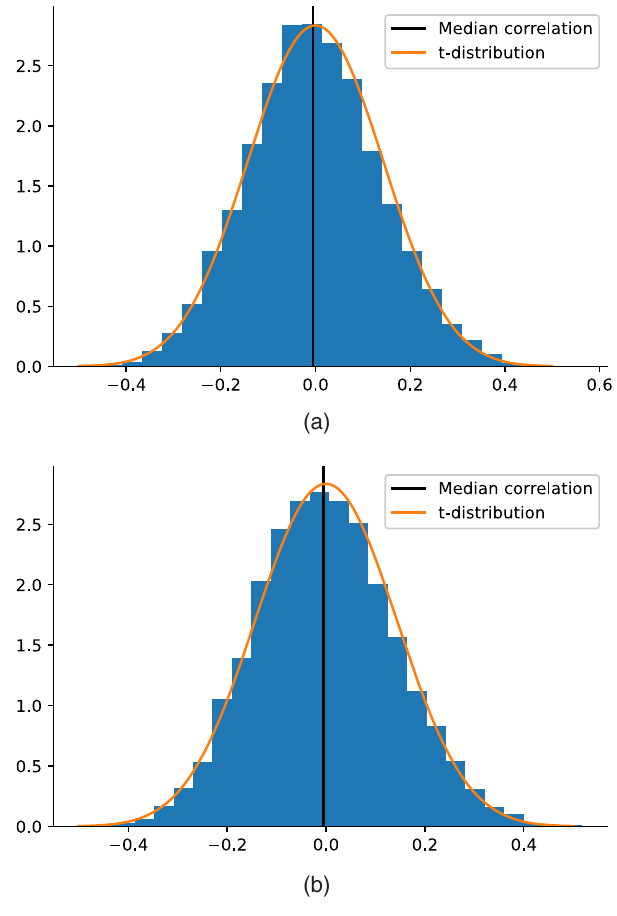
FIG. 10. Histogram of correlations between grades and inward harmonic centrality, c Hi , in networks simulated with the DD method and 36% of nodes removed based on the nodes ’ centrality. (a) Preferentially dropping nodes with high centrality, and (b) Preferentially dropping nodes with low